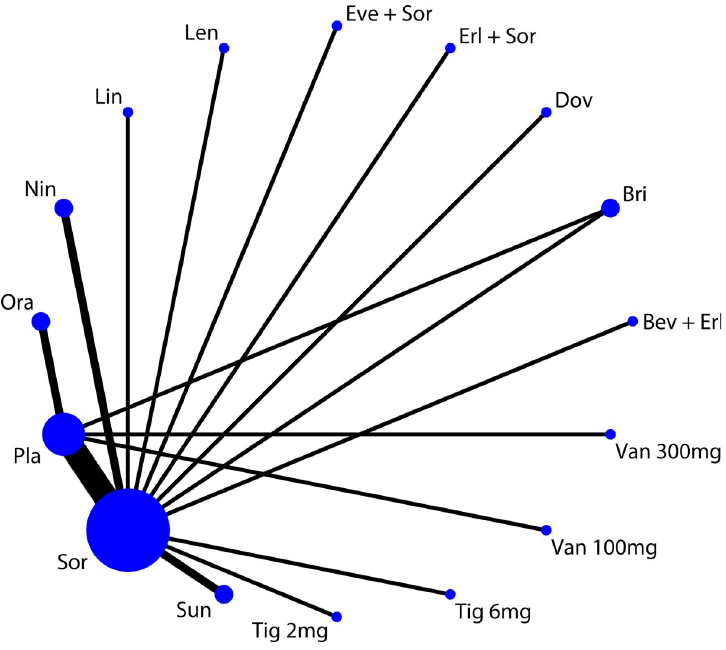
Fig 2. Network diagram of all